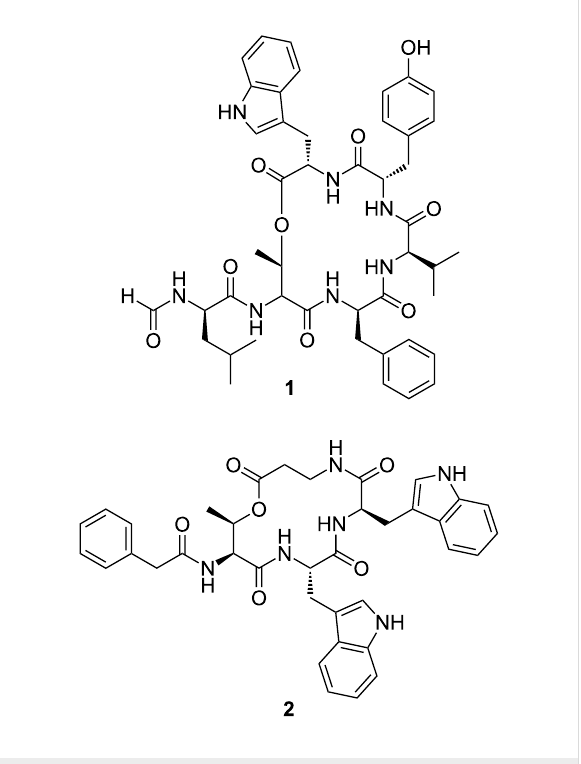
Figure 1: Structure of depsipeptides szentiamide ( 1 ) [12] and xene- matide ( 2 ) [8] identified in Xenorhabdus strains.